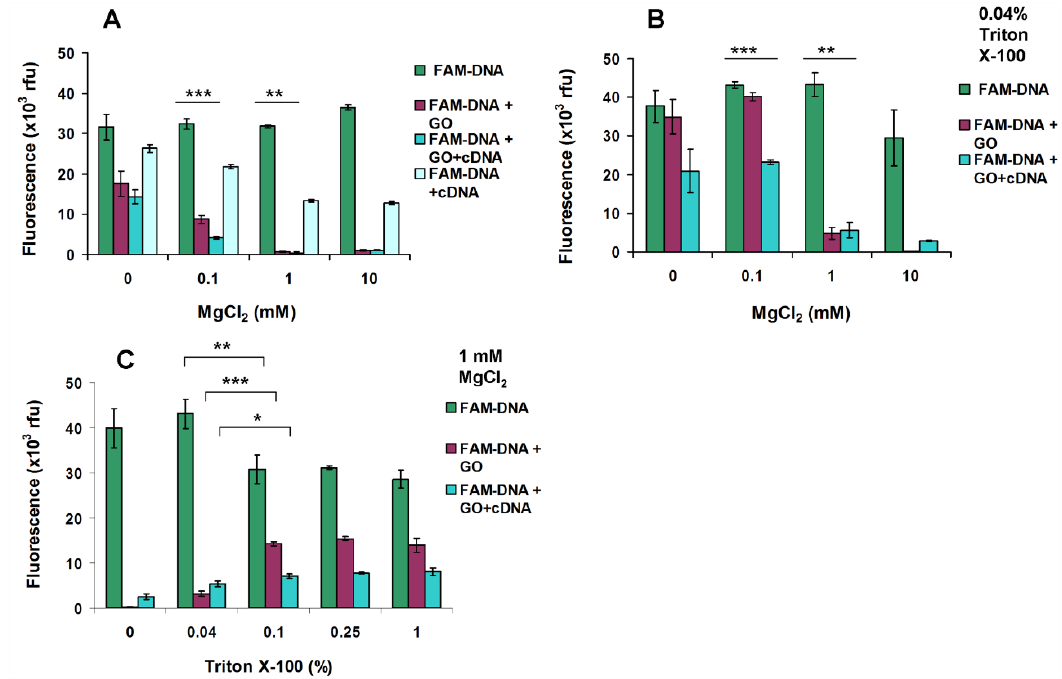
Figure 3. Triton X-100 reduced the FAM–DNA binding to GO in the presence of MgCl 2 . ( A ) The e ff ect of MgCl 2 concentration on fluorescence signal from single stranded FAM–DNA alone and with the addition of GO, with or without the cDNA target. FAM–DNA combined with cDNA alone was compared as a control. ( B ) The e ff ect of 0.04% (0.64 mM) Triton X-100, on FAM–DNA / GO interaction with increased MgCl 2 concentration. ( C ) The e ff ect of Triton X-100 concentration on FAM–DNA / GO interaction at a constant of 1 mM MgCl 2 in 10 mM Tris-HCl, pH 8.0. For ( A – C ), 100 nM L − 1 FAM–ssDNA, 100 nM L − 1 cDNA and 10 µ g / mL GO. All the data were acquired at 23 ◦ C and 1 h incubation time. Error bars represent standard deviation (SD) of n = 3. p -values; * p ≤ 0.1, ** p ≤ 0.01, *** p ≤ 0.001.